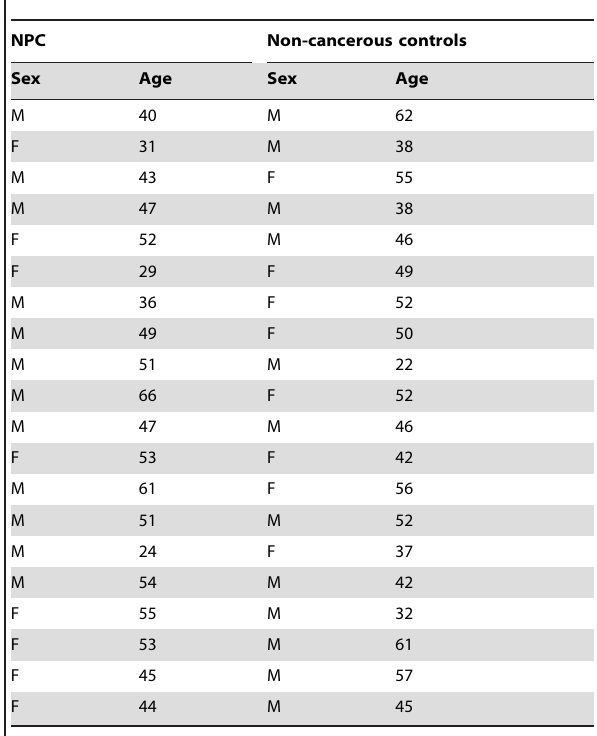
Table 2. Age and sex constitution of 20 NPC patients and 20 non-cancerous volunteers from whose serum collected used for TLDA miRNA